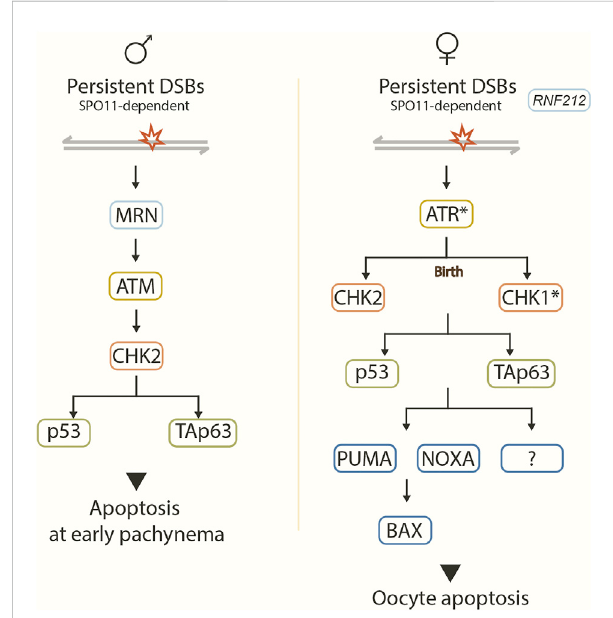
FIGURE 2 Recombination checkpoint pathway. Model showing the proposed signaling pathway in response to unrepaired SPO11- dependent DSBs in male (left) and female (right) mice. Asterisks represent predicted checkpoint factors. In males, DSBs are sensedbytheMRNcomplex,leadingtotheactivationofATM,whichin turn activates effector CHK2. CHK2 acts on target proteins p53 and TAp63, which implement the recombination-dependent arrest that blocks progression to mid/late pachynema. In females, RNF212 prevents the repair of residual DSBs in the late prophase. Unrepaired DSBs likely activate ATR, which may activate CHK2 before birth and CHK1 after birth. CHK1 and CHK2 signal to p53 and TAp3. Pro-apoptotic BCL-2 pathway components PUMA, NOXA, BAX, and other unknown factors act downstream to trigger oocyte